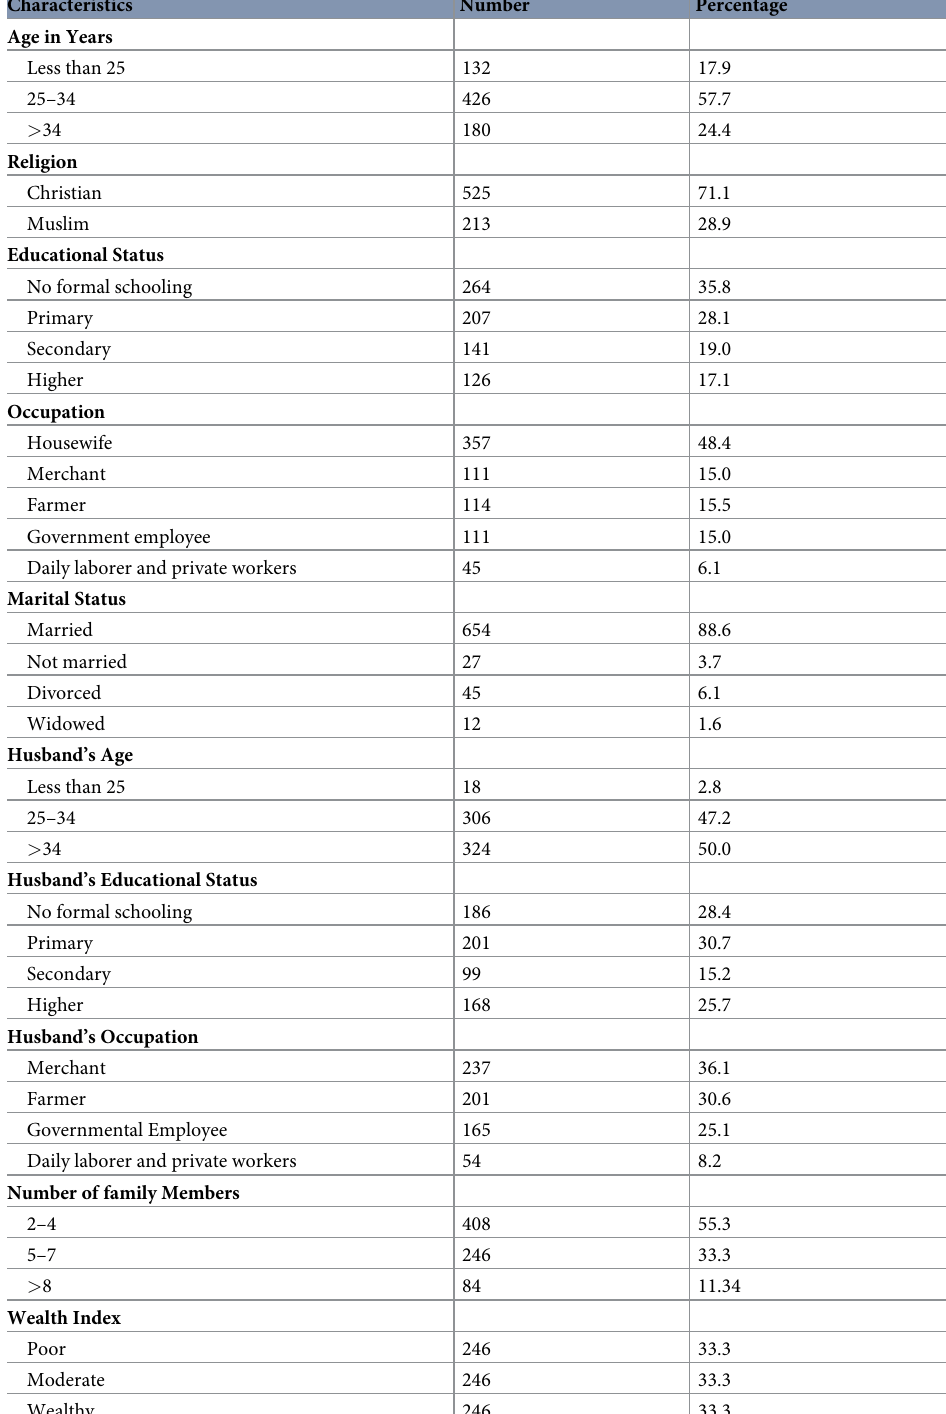
Table 1. Sociodemographic characteristics of the study participants.